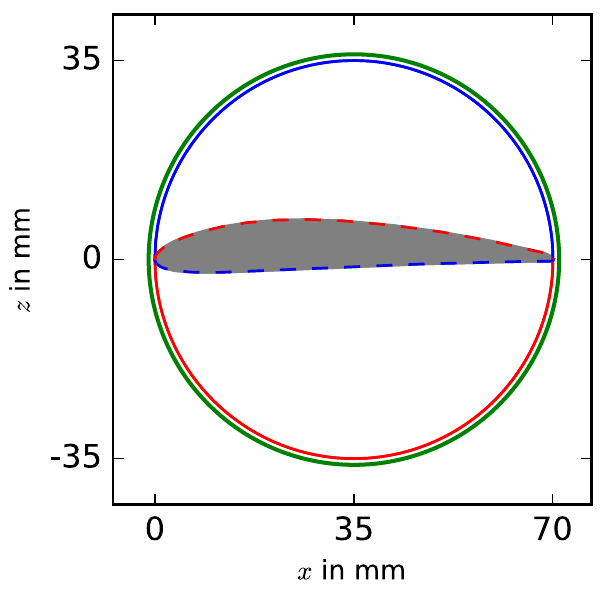
Figure 1. End plate geometries on NACA 4412 (grey), full circle with diameter corresponding to the chord length of 70 mm (green), half circle on suction side (blue), half circle on pressure side